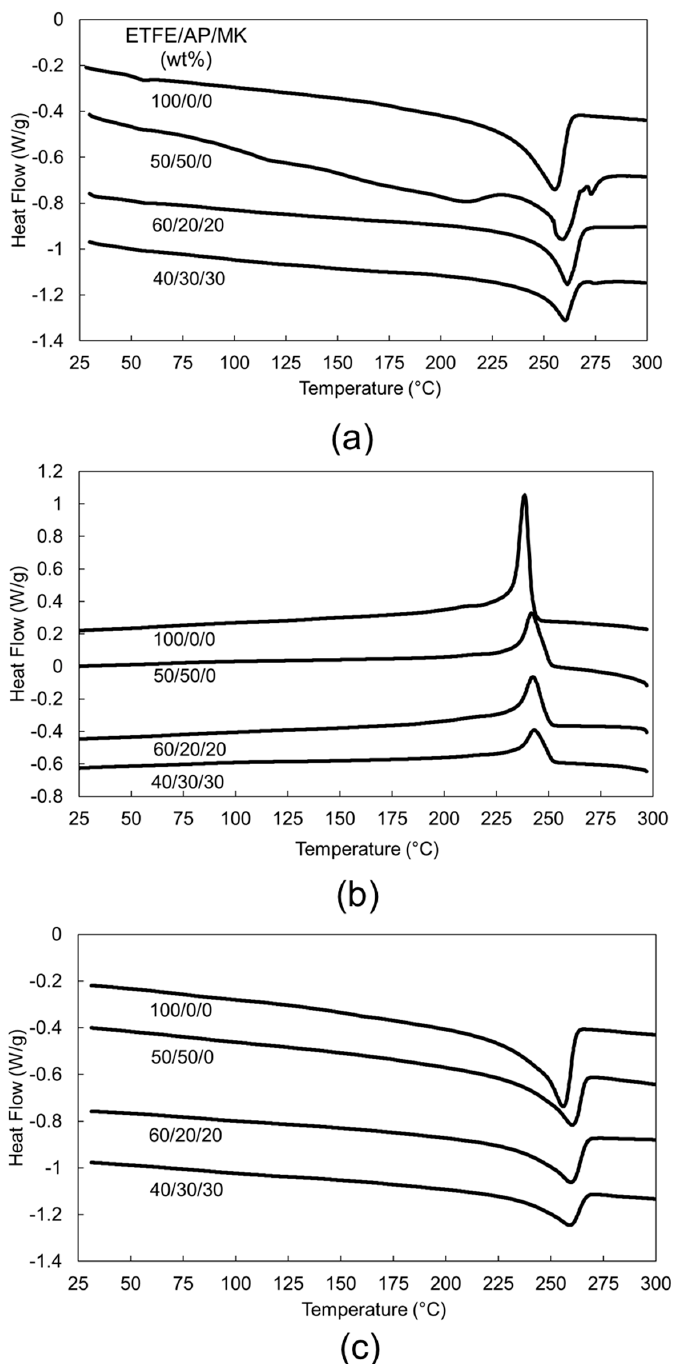
Figure 3. Differential scanning calorimetry (DSC) curves of selected ETFE/AP/MK composites, ( a ) first heating stage, ( b ) cooling stage, and ( c ) second heating stage. The origin of those additional peaks, which disappear during the subsequent cooling and the second heating stages, may be explained by the presence of residual unreacted since the second heating stage does not exhibit the corresponding peaks. One important consequence of those peaks is that the melting enthalpy of ETFE cannot be calculated with